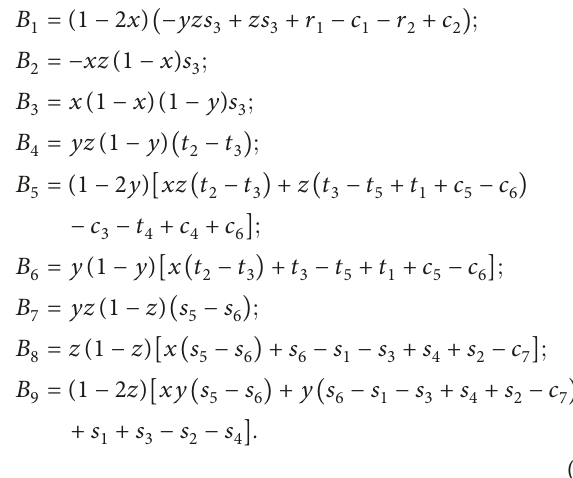
Table 1: Variables in the game among the organization, miners, and